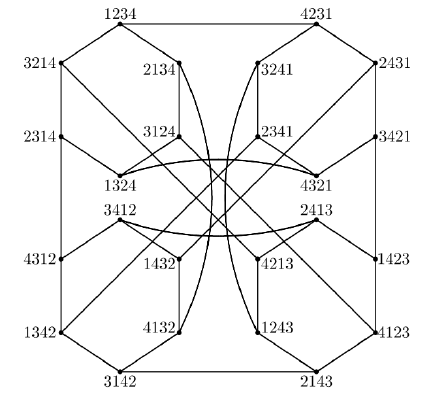
Figure 1. The star graph ST 4 = Cay ( S 4 , { ( 12 ) , ( 13 ) , ( 14 ) } ) .